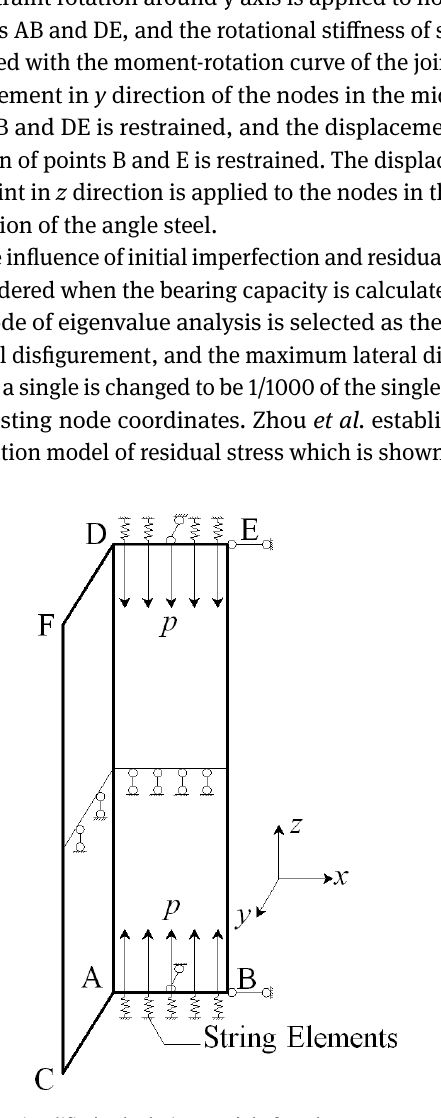
Figure 13: Simplified calculation model of angle